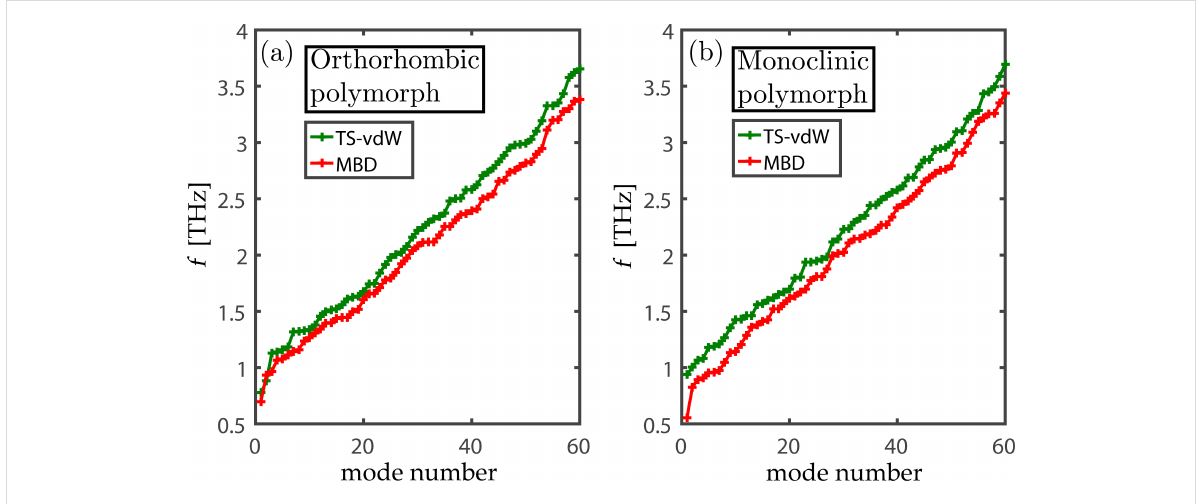
Figure 5: THz vibrational frequencies, as a function of mode number, obtained for the orthorhombic (a) and monoclinic (b) polymorphs of TNT using the TS-vdW and MBD approaches.